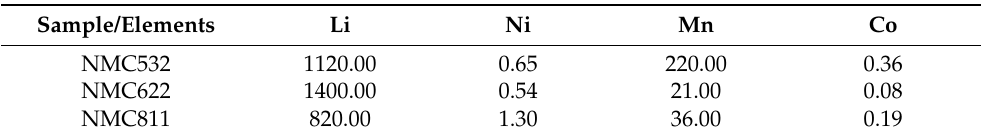
Table 6. Results of the ICP-MS analysis for Li, Ni, Mn, and Co of the H 2 SO 4 acid in the gas scrubber after the InduMelt experiments (concentration, mg L − 1 ).